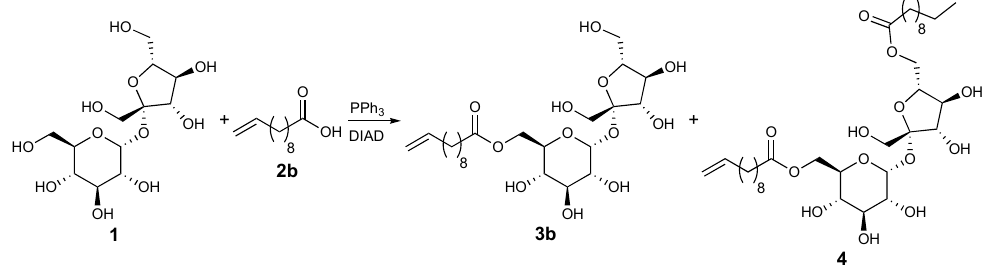
Scheme 1. Model reaction for methodology studies. Table 2. Investigation of the conditions for Mitsunobu-type reaction between sucrose and undecylenic